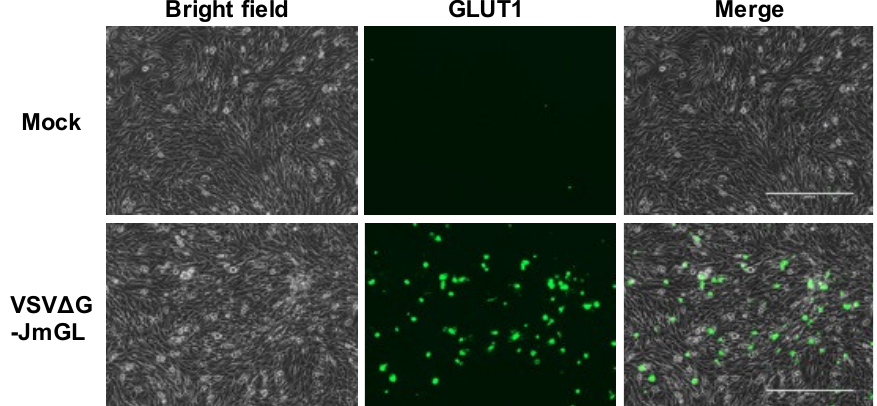
Figure 2. Expression of the STLV-1 receptor molecule on the rVSV-infected target cell surface. The surface expression of JM GLUT1 protein after VSV infection was confirmed by immunofluorescence staining. VSV-permissive BHK-21 cells were infected with G-complemented VSVΔG-JmGL at an MOI of 0.1. After 1 day of culture, JM GLUT1 expressed by the viral genome was stained with anti-GLUT1-specific mouse monoclonal antibody (MAb) followed by FITC-conjugated anti-mouse IgG. The stained cells were observed by fluorescence microscopy and photographed at a constant magnification. Scale bars in panels represent 400 µm.